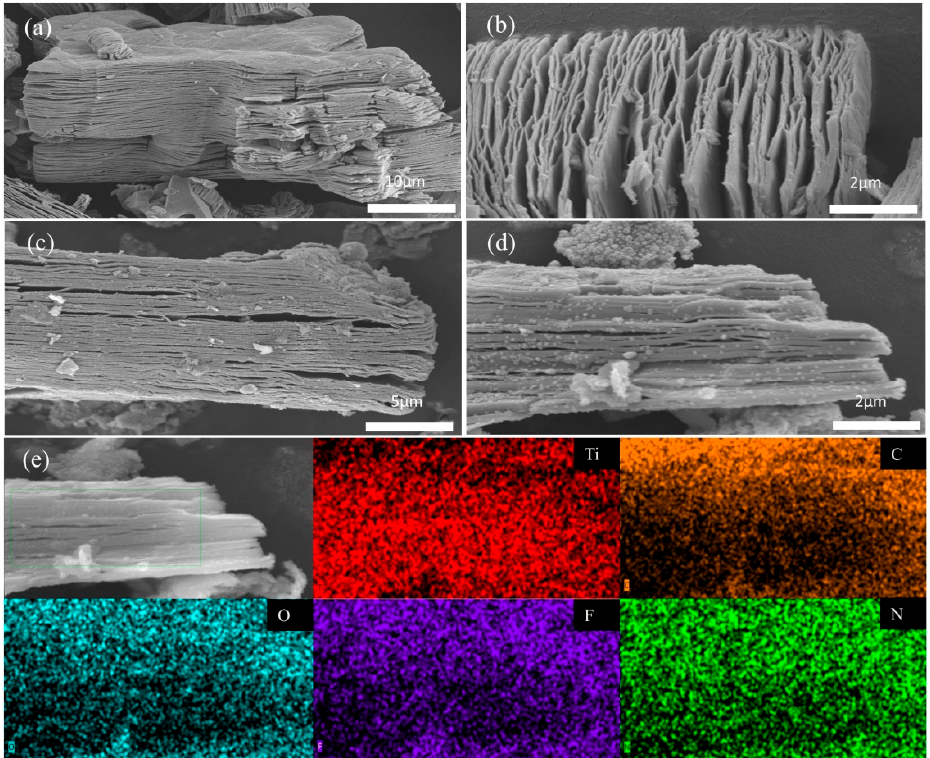
Figure 3. ( a , b ) Local magnifications of layered Ti 3 C 2 MXene and Ti 3 C 2 ; ( c , d ) SEM images of N − Ti 3 C 2 MXene nanomaterials at different magnifications; ( e ) EDS elemental mapping of Ti, C, O, F and N nanomaterials of N − Ti 3 C 2 MXene.